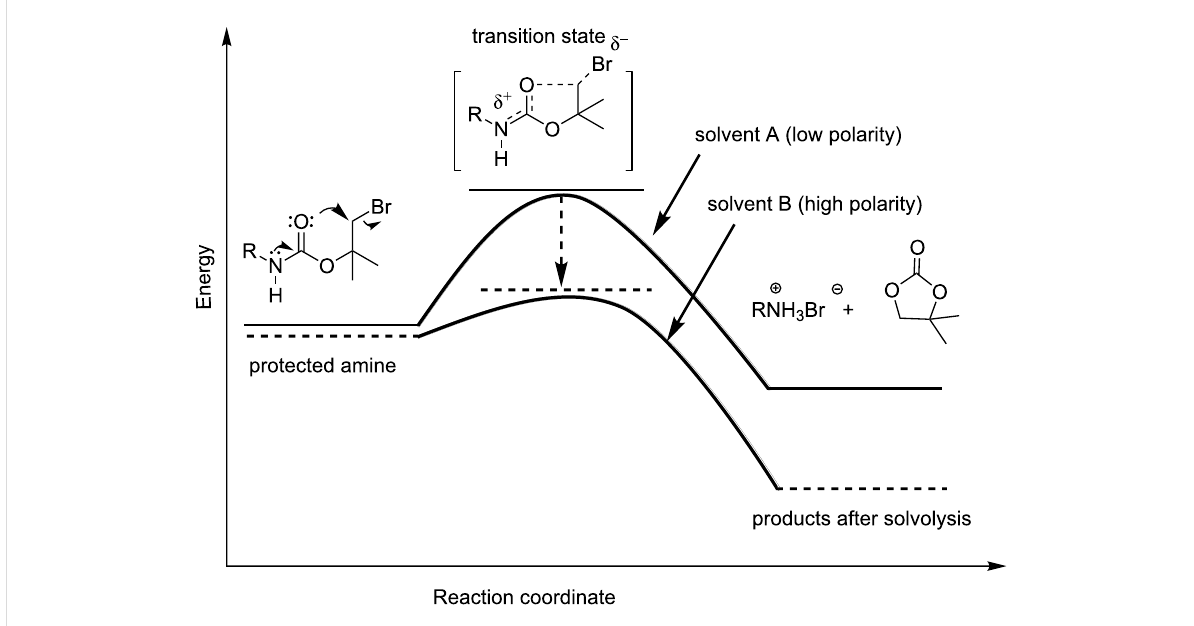
Figure 1: Schematic representation of a deprotection taking the relatively high polarity of the transition state and the solvent polarity into account: high activation energy in nonpolar solvents and low activation energy in polar solvents.